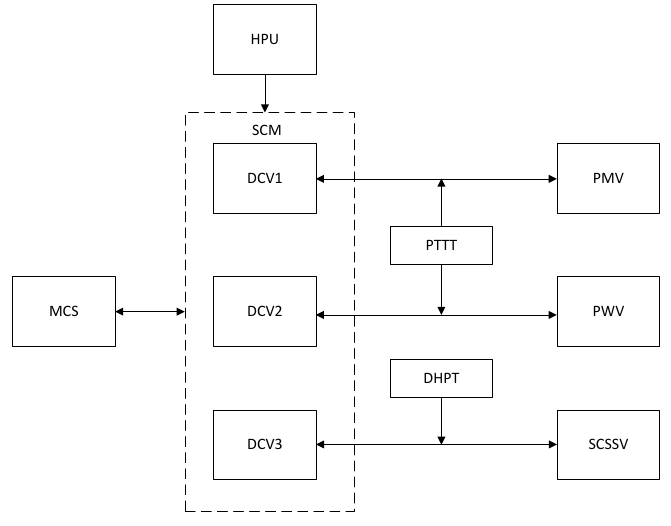
Figure 7. Function diagram of subsea emergency shutdown